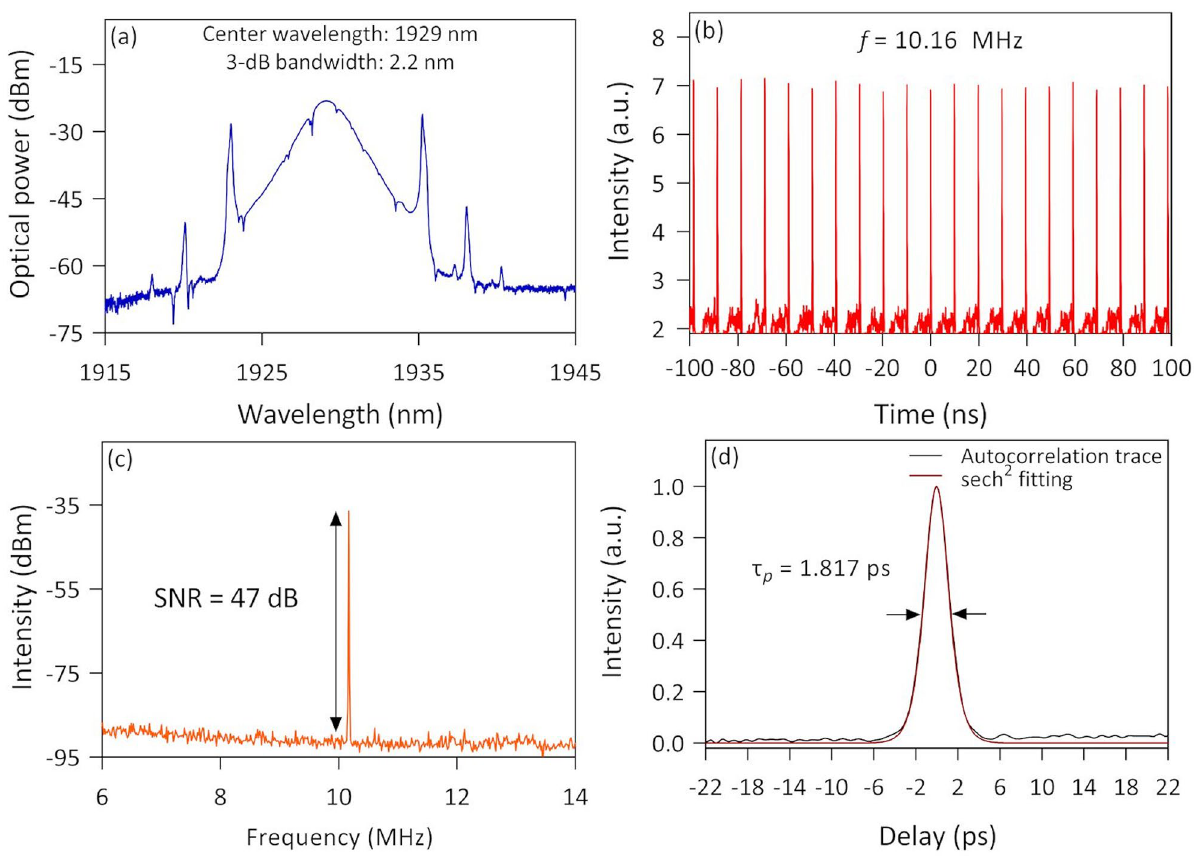
Figure 13. The output characteristic for mode-locked thulium-doped fiber laser using Ta 2 AlC arc-shaped fiber saturable absorber: ( a ) Optical spectrum, ( b ) soliton train, ( c ) radio frequency spectrum, and ( d ) autocorrelation